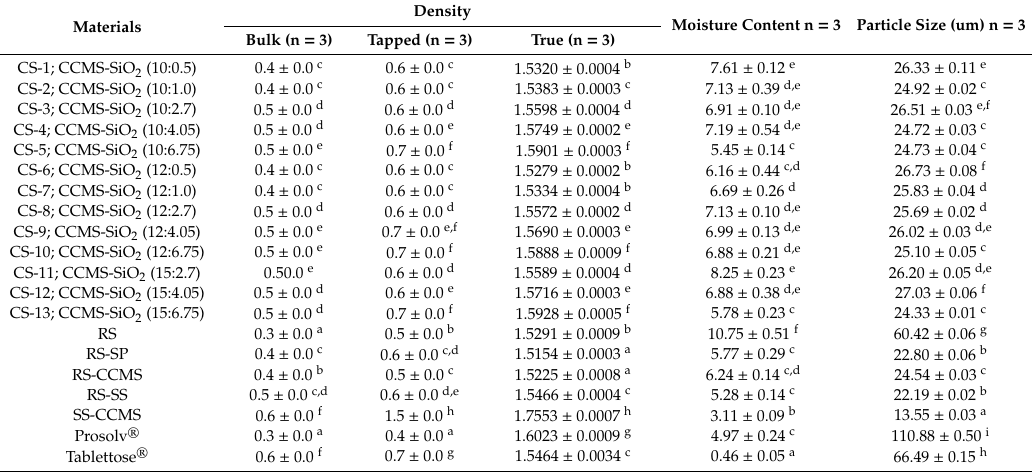
Table 2. Density, moisture content, and particle size of CSs, RS, RS-SP, and commercial DC excipients.